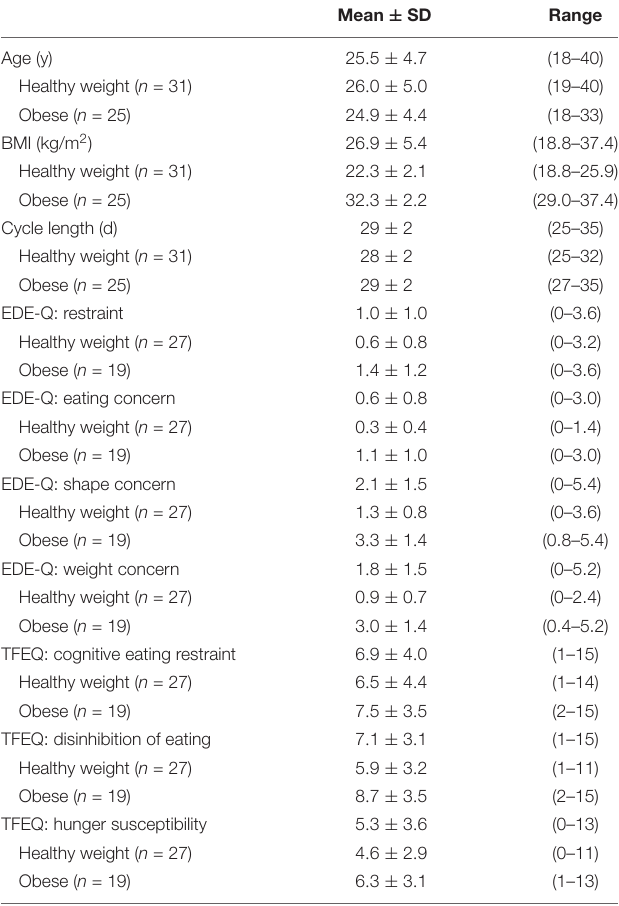
TABLE 1 | Demographics of the participants fulfilling the inclusion